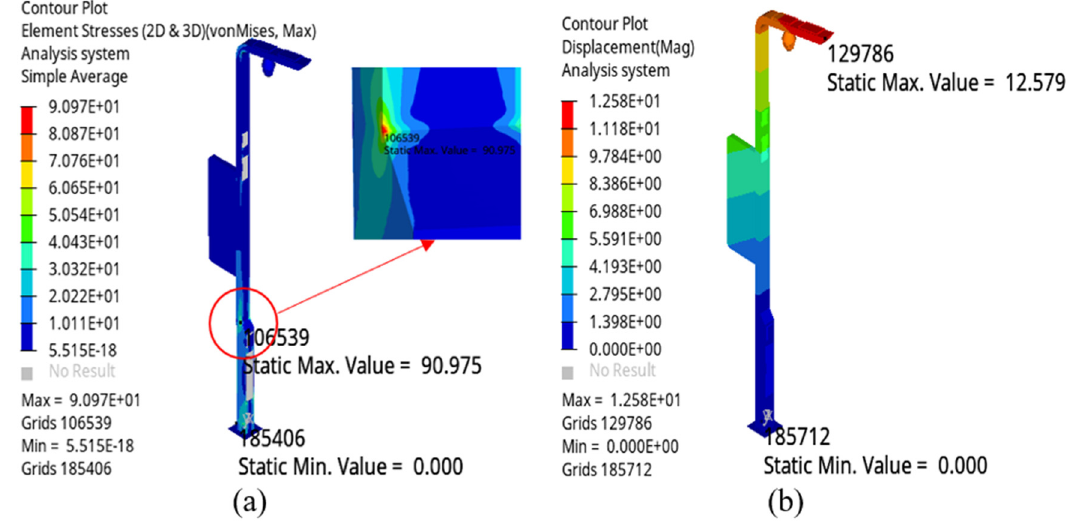
Figure 7: The cloud diagram under full load condition of wind and snow: ( a ) stress and ( b )